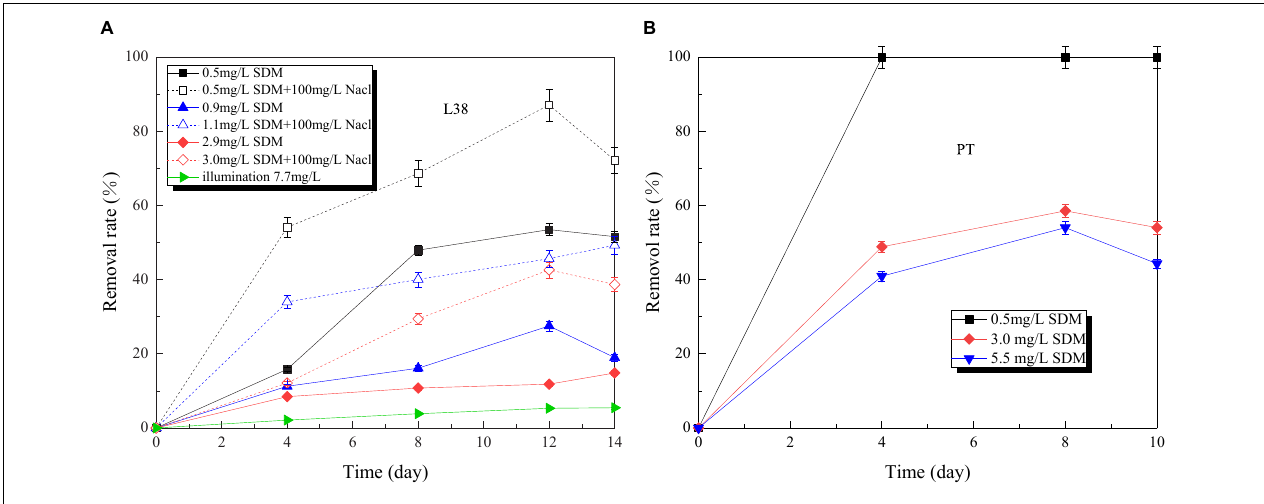
FIGURE 6 | SDM removal rate variation of Chlorella sp. L38 (A) and Phaeodactylum tricornutum MASCC-0025 (B) under different initial concentration.